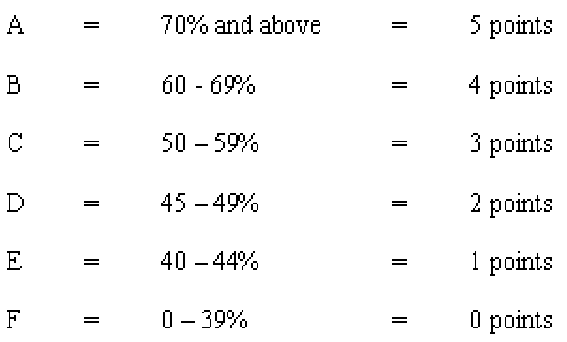
Table 1. GPAs as based on criteria established by the National Universities Commission’s (NUC)